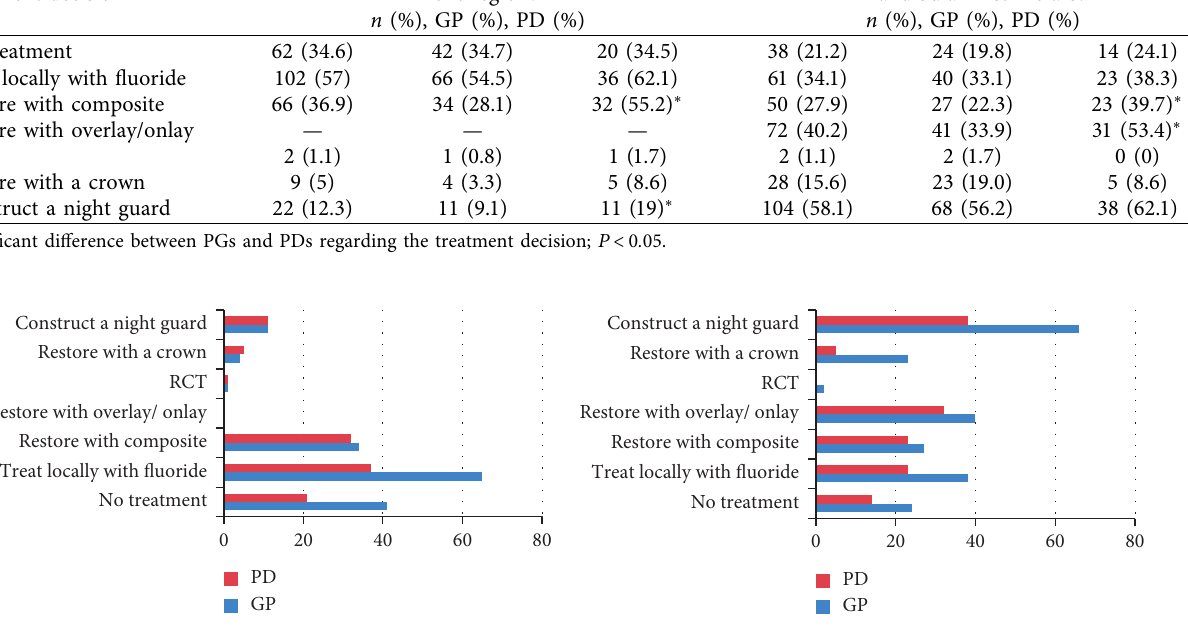
Table 3: The frequency of treatment decisions and ( n ) the number of GPs and PDs responding to each treatment option for clinical case one. How would you treat the maxillary Treatment decision front